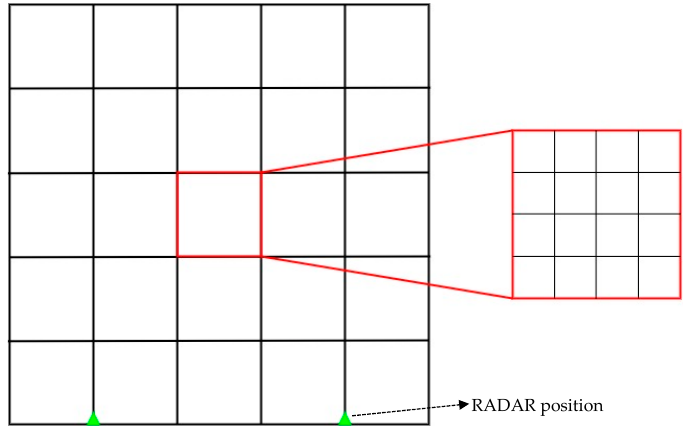
Figure 3. Describe the valid target positions of the indoor environments.